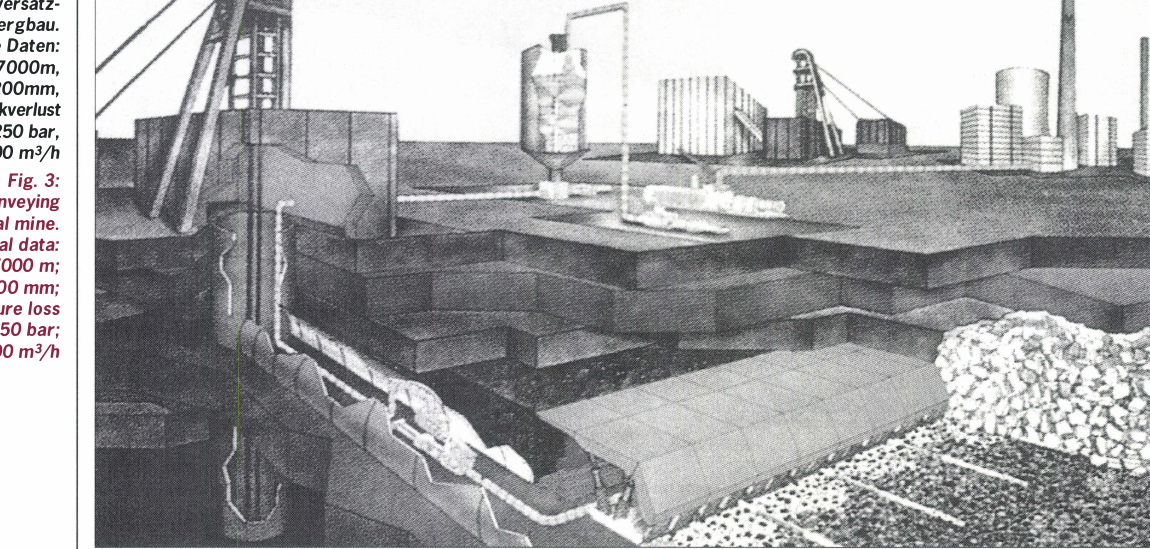
Fig. 3: Principles for conveying slurry in a coal mine. Typical data: pipeline length 7000 m; pipe diameter 200